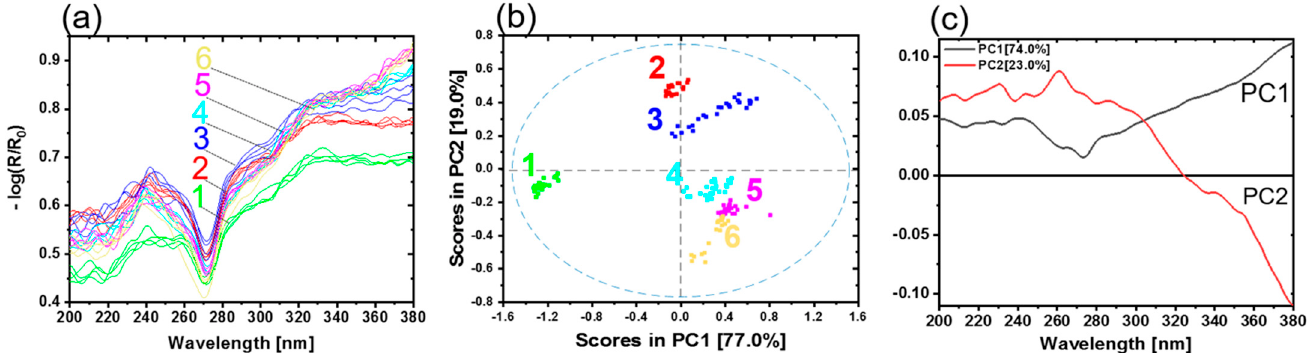
Figure 5. ( a ) Average UV hyperspectral imaging spectra of copper sheets. Copper with initial condition type 1 (green), 2 (red), 3 (blue), 4 (light blue), 5 (pink) and 6 (yellow) represent the oxidation layer thicknesses 0 nm, 4 nm, 8.3 nm, 14 nm and 21.1 nm, respectively. ( b ) PCA with scores and ( c ) the corresponding loadings.